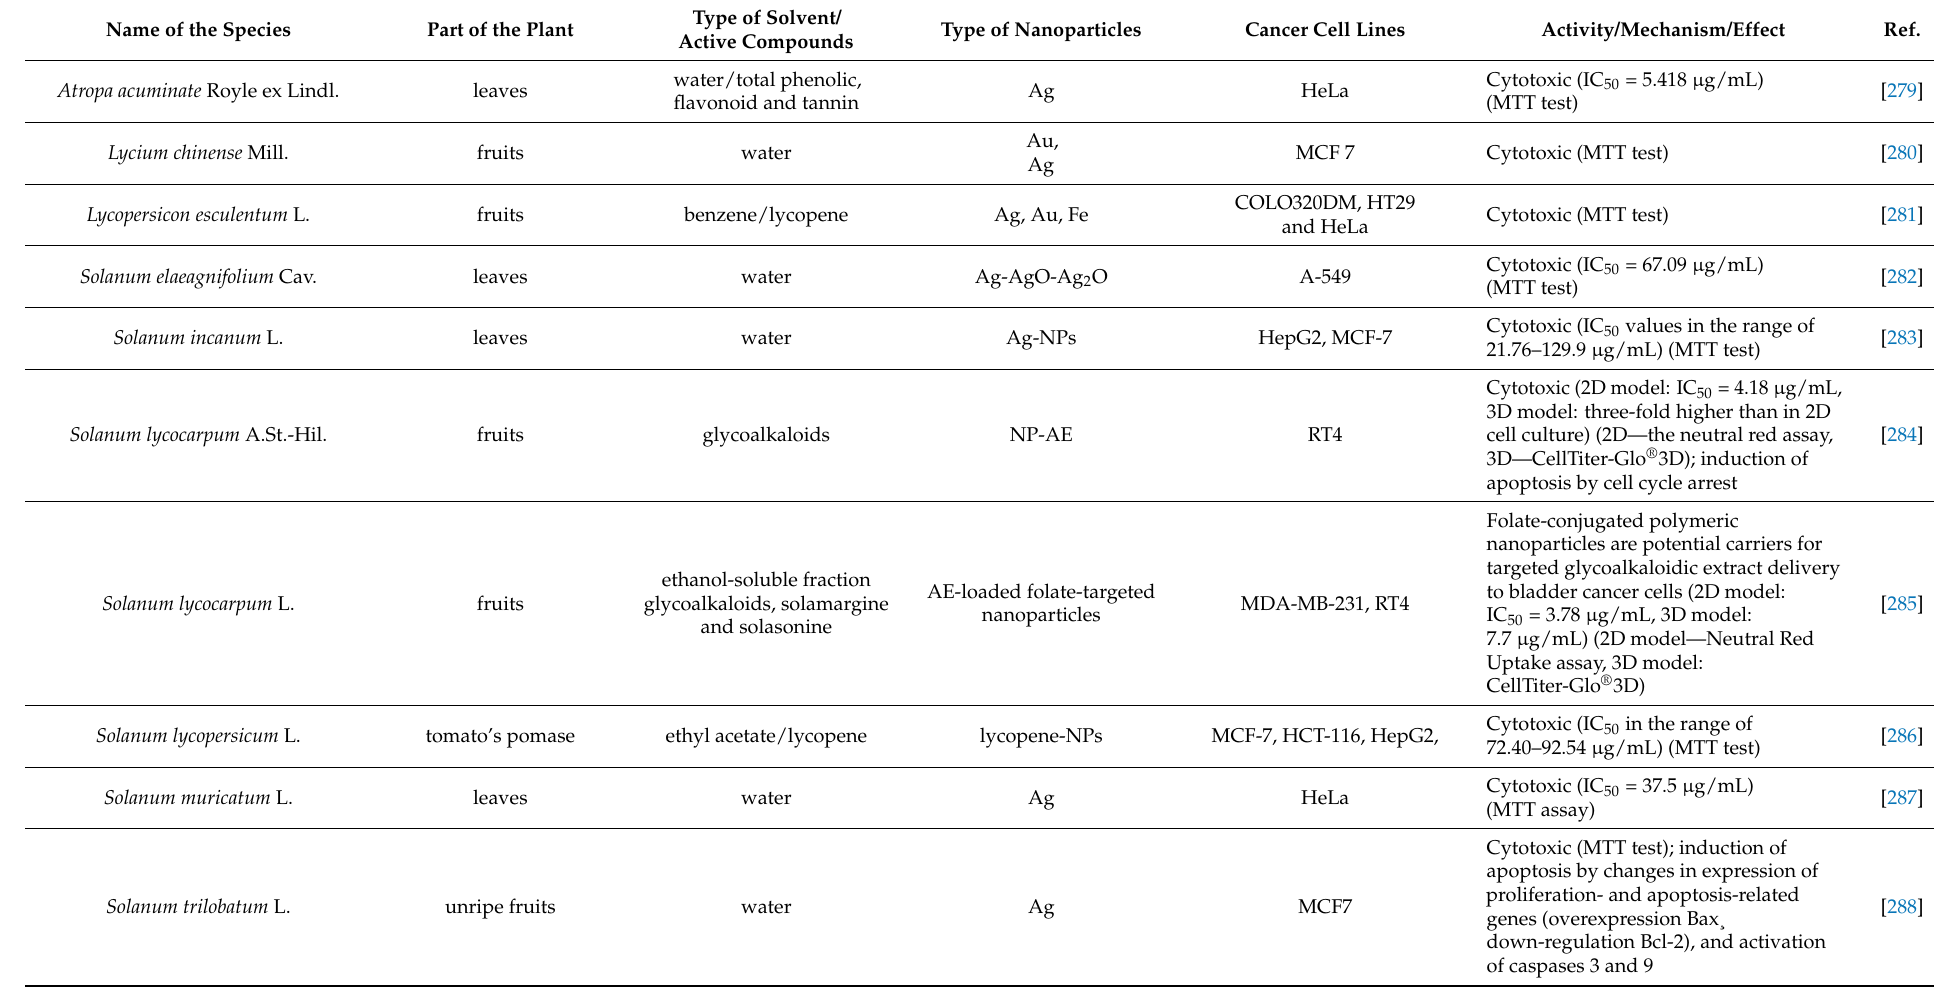
Table 3. Anticancer effect of nanoparticles in combination with plant extracts from the Solanaceae family, and their potential mechanisms of